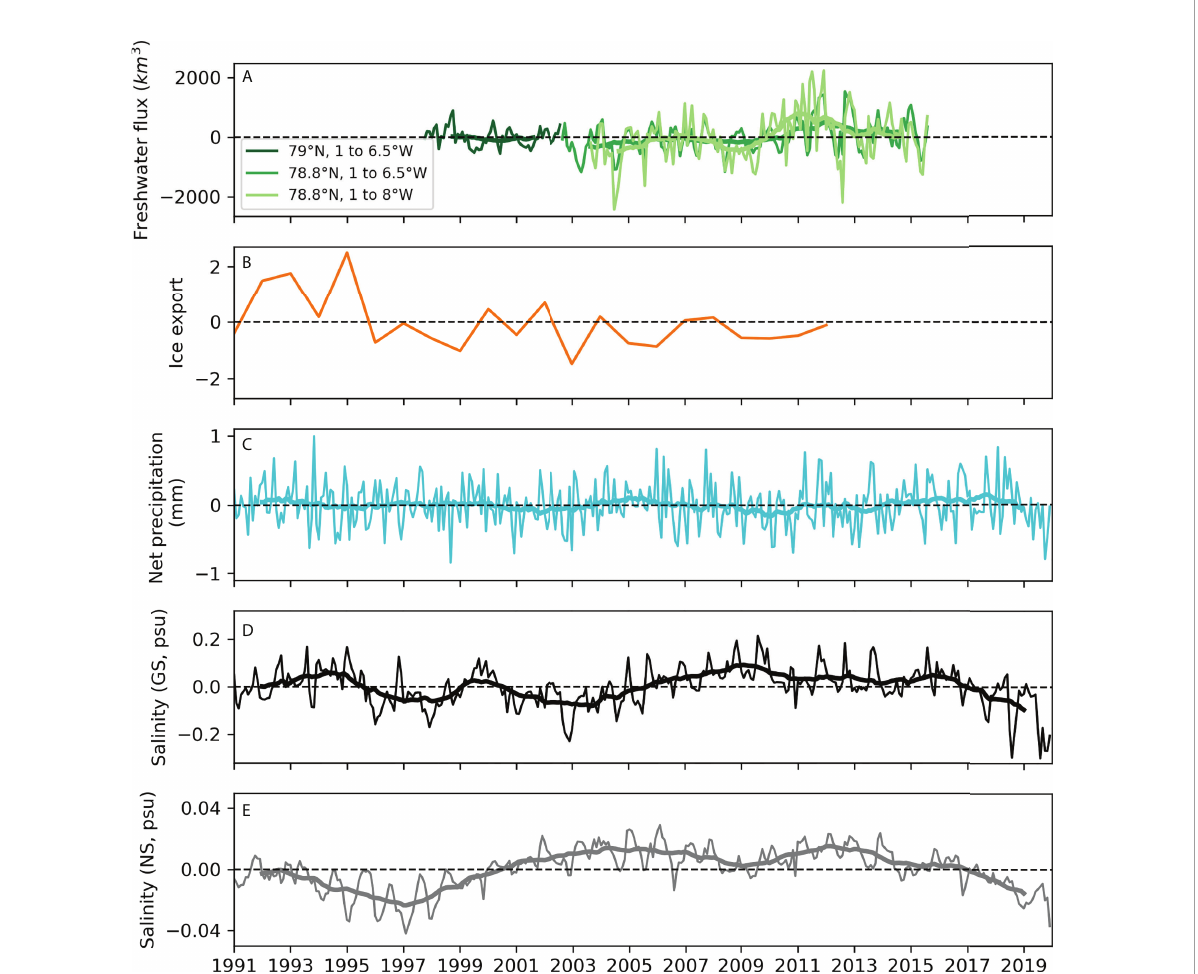
FIGURE 14 Time series of (A) southward fl ow of freshwater anomaly at the Fram Strait, (B) annual ice export index at the Fram Strait (78.9°N) during 1991- 2012 inferred from Wei et al. (2019), (C) net precipitation anomaly over the Nordic Seas, and near-surface salinity anomalies in (D) the Greenland Sea and (E) the Norwegian Sea during the period of 1991-2019. The bolder lines represent the 25-running mean of each time